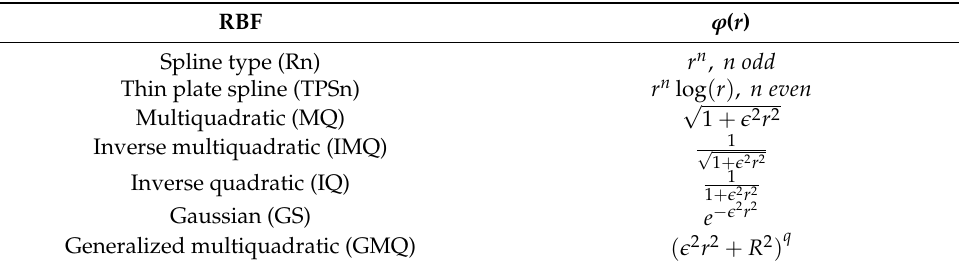
Table 1. Most common radial basis functions.